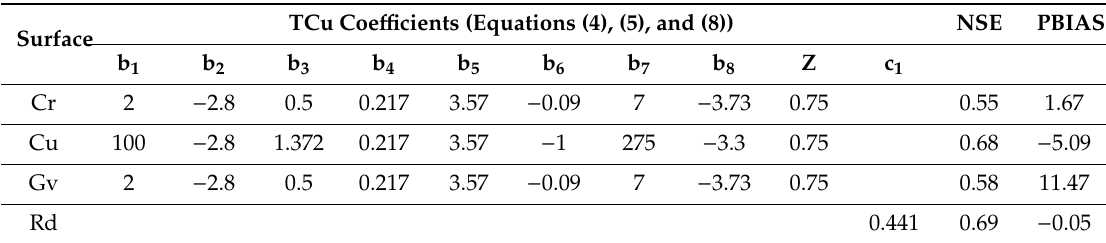
Table A6. Optimized MEDUSA2.0 model coe ffi cient values and goodness of fit statistics for TCu. Surface